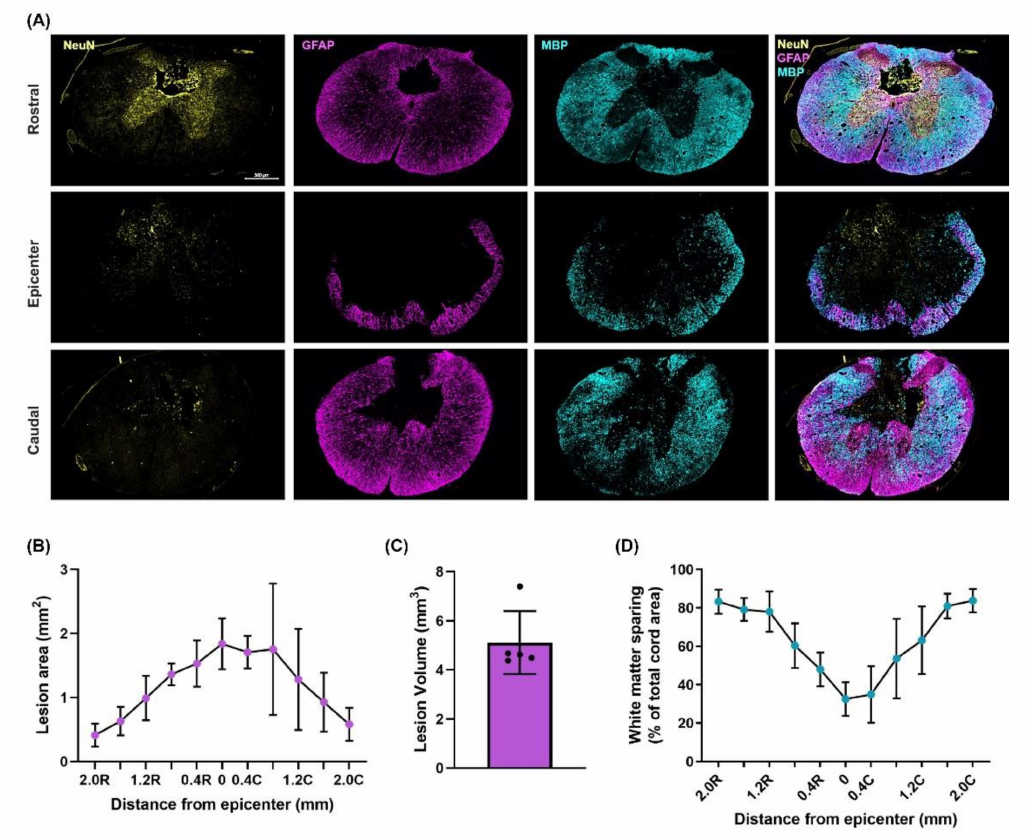
Figure 5. Lesion site characterization. ( A ) Representative immunohistological images of the rostral (top), epicenter (middle), and caudal (bottom) sections. Stains from left to right are Neuronal Nuclei (NeuN), Glial Fibrillary Protein (GFAP), Myelin Basic Protein (MBP), and the merged stain. Data were quantified every 400 µ m from the lesion epicenter to a distance of 2 mm rostrally and caudally (n = 5). ( B ) The GFAP signal was used to quantify lesion area which reached an area of 1.75 ± 0.40 mm 2 at the epicenter. Data points and bars represent the mean and standard deviations, respectively. ( C ) Lesion volume was calculated as Volume = Σ (area · section thickness · number of sections between samples) [24] and was found to be 4.26 ± 1.28 mm 3 . Bars represent the means and standard deviations overlaid with individual data. ( D ) White matter sparing was quantified using the MBP signal and reached a minimum sparing at the epicenter of 33 ± 9%. Data points and bars represent the mean and standard deviations,